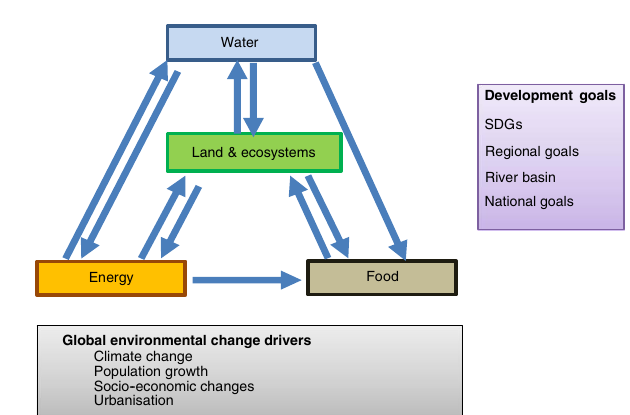
Figure 1. Illustration of linkages between WEF and Land and